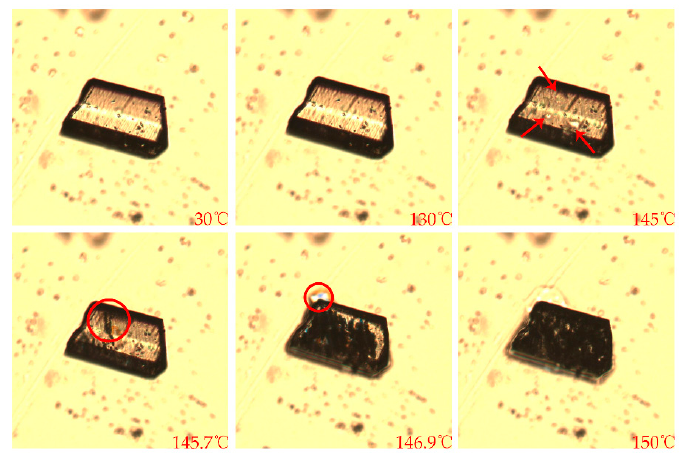
Figure 10. HSM images of NS-MeOH. The tiny bubbles and the cracks were pointed by red arrows and circles, respectively.